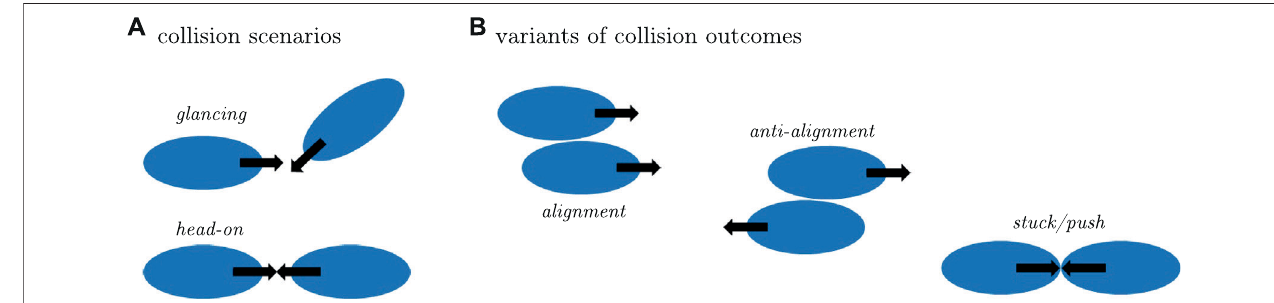
FIGURE 2 | (A) Graphical illustration of the different collision scenarios and (B) the respective outcome of the interaction. Initial conditions for binary collision are glancing(top)andhead-on collision(bottom).Theinteraction mayresultinalignmentofcells,anti-alignment ofvelocities andcellpolaritiesorcellsmaystuck/pushhead- on, thereby impeding each others